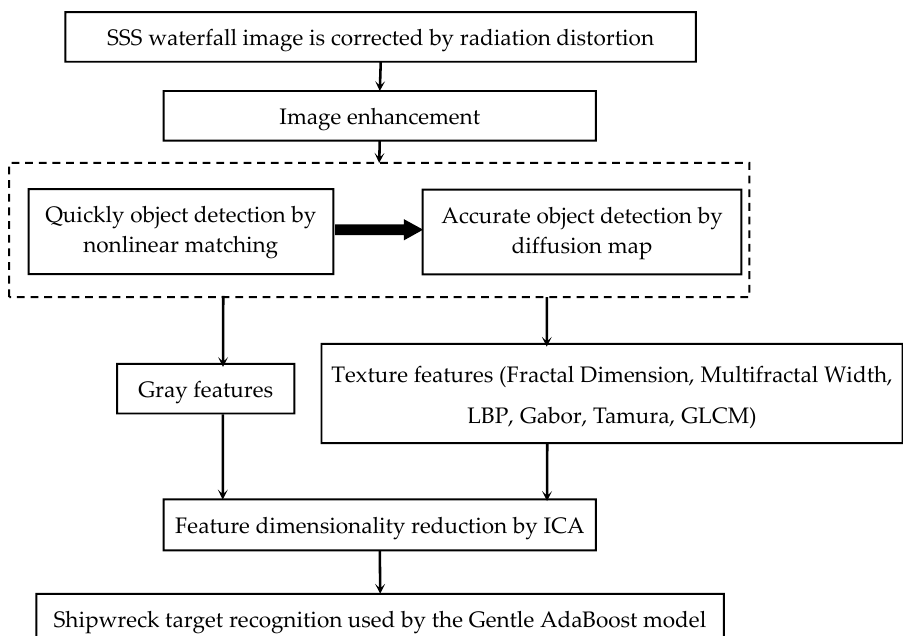
Figure 4. Shipwreck target recognition process for SSS waterfall image [8,30–32].